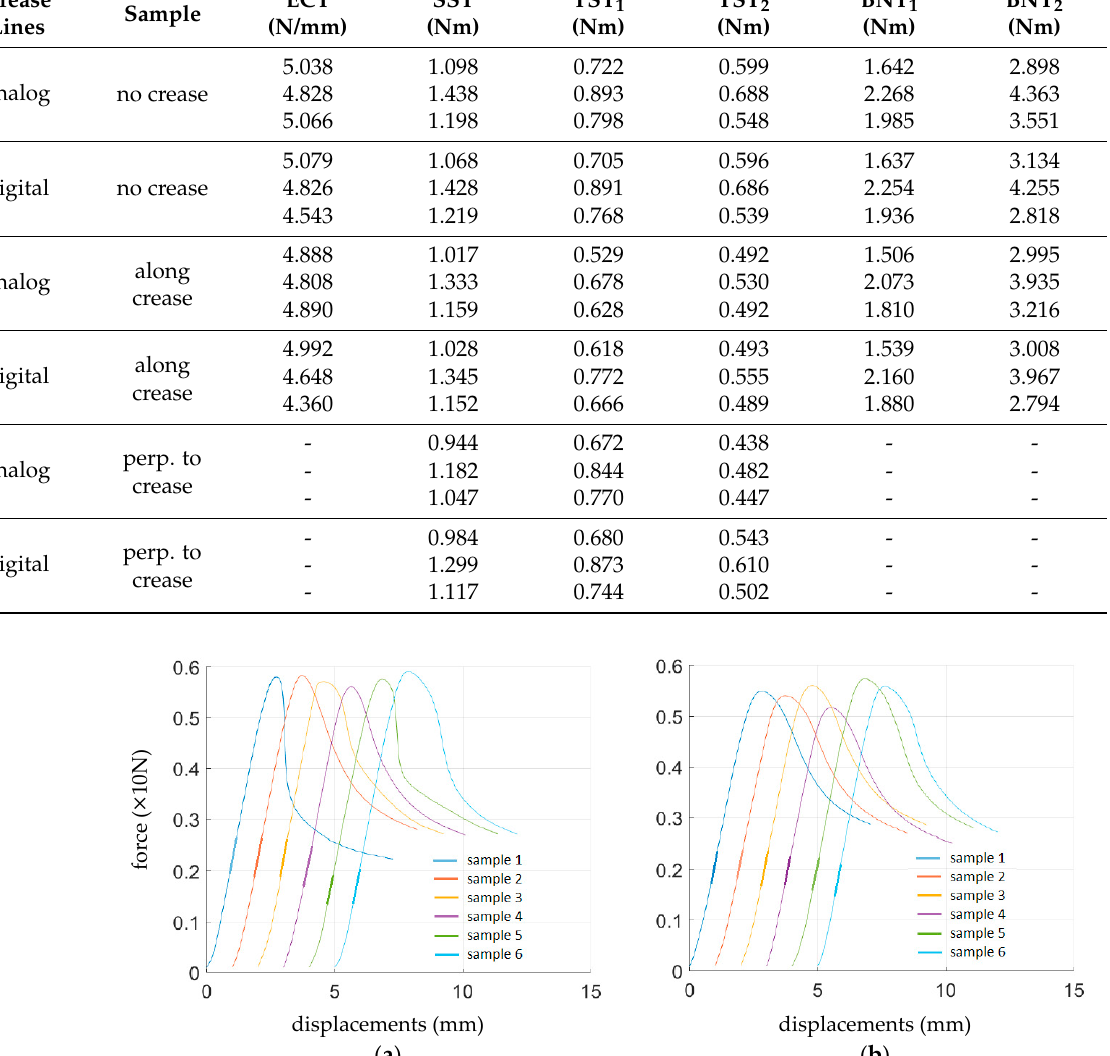
Figure 9. Bar plots of percentage differences between results for crease-free region samples and samples with a crease along the sample length.